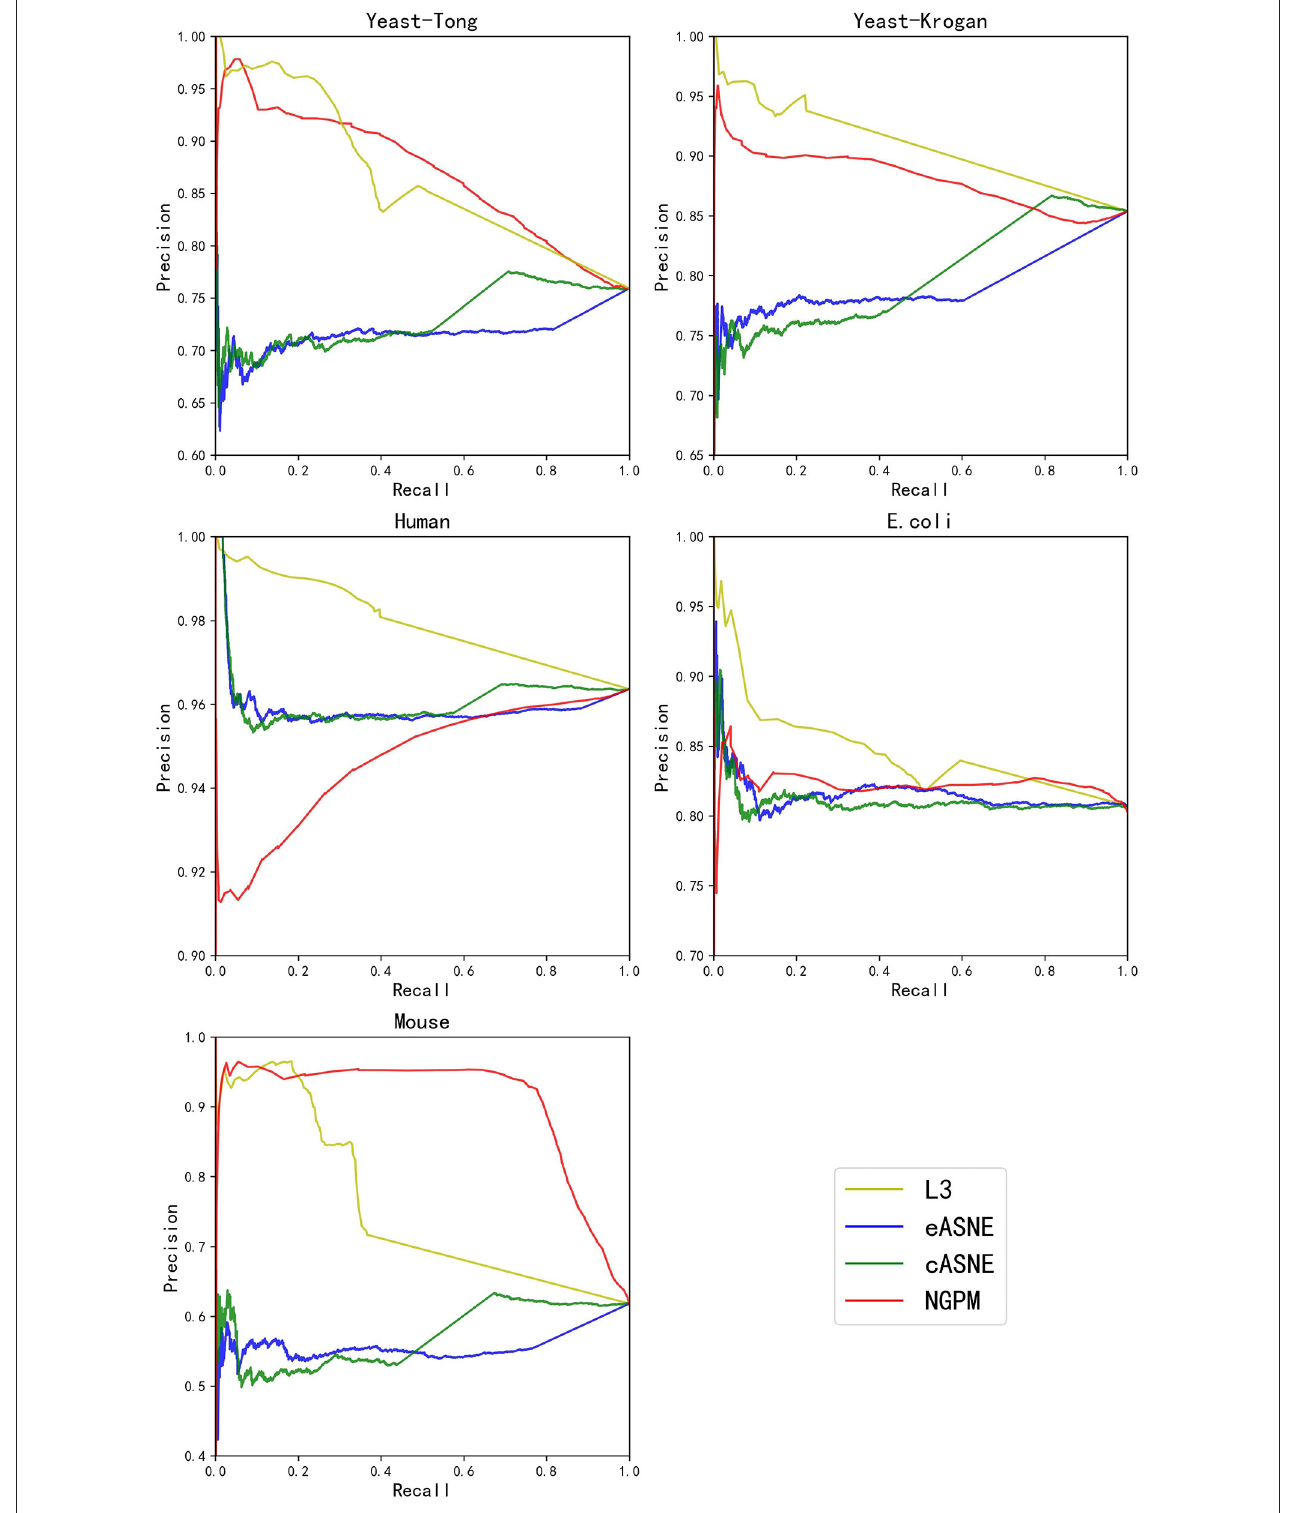
FIGURE 5 | The PR curves of L3, eASNE, cASNE, and NGPM.